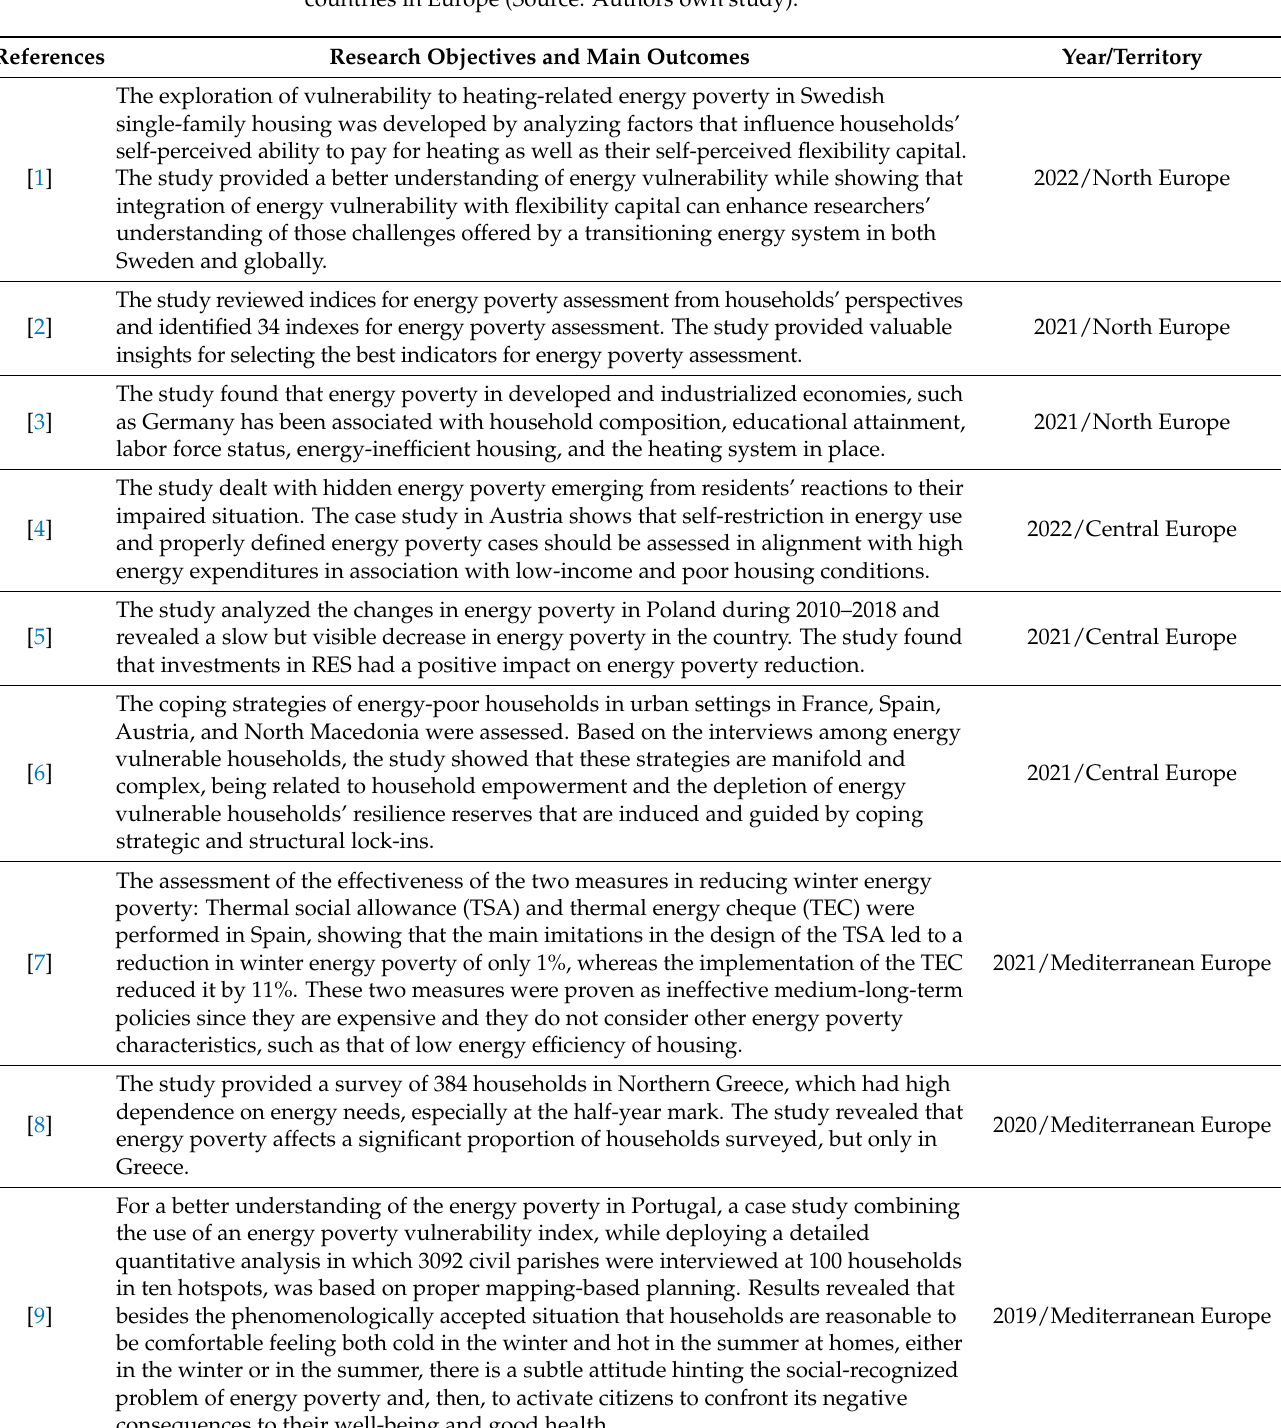
Table 1. Allocation of research and objectives and main outcomes among developing and developed countries in Europe (Source: Authors own